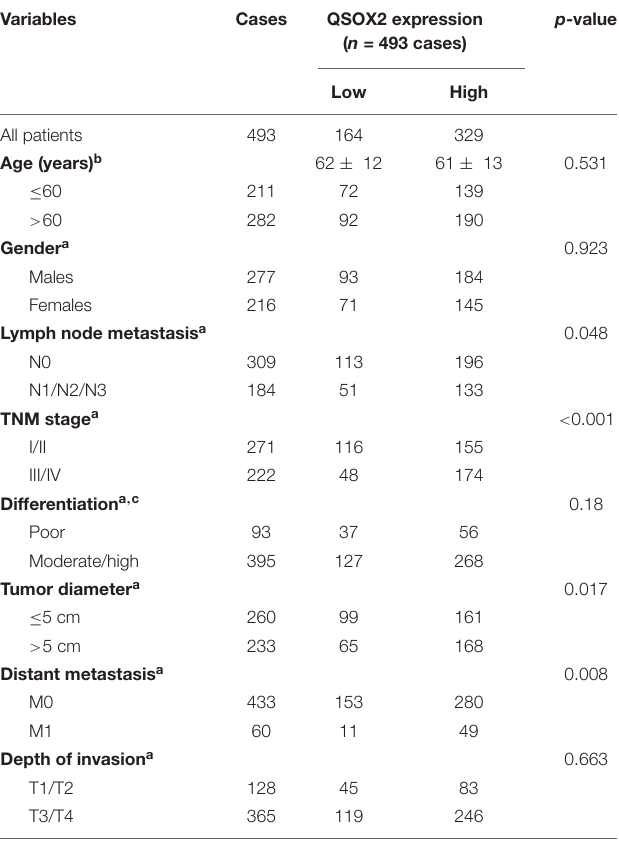
TABLE 5 | Relationship between QSOX2 expression and clinicopathological features of CRC patients based on clinical CRC specimen cohort.